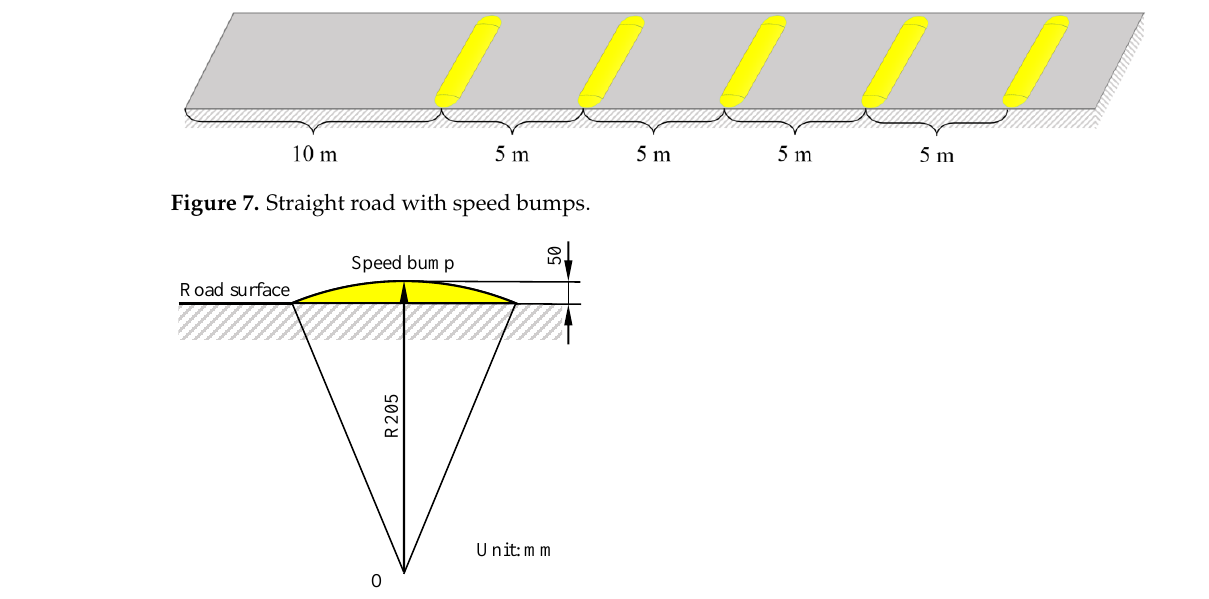
Figure 8. The section shape of the speed bump.